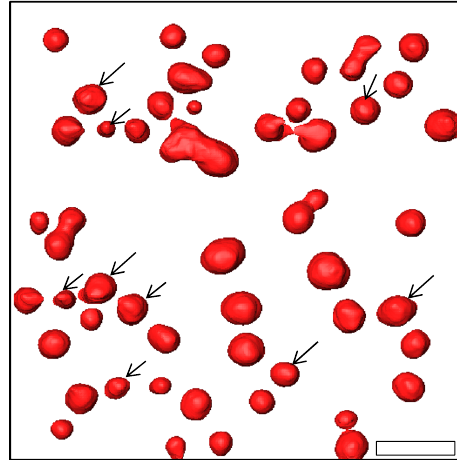
Fig. 2 Electron tomography characterization of the Pt nanoparticle shape. 3D volume rendering, viewed from the top, of Pt nanoparticles synthesized with the O 2 -based ALD process (Pt loading ~45 atoms per nm 2 ). The arrows indicate particles that exhibit a fl at surface at the Pt/SiO 2 interface. The scale bar indicates 10 nm